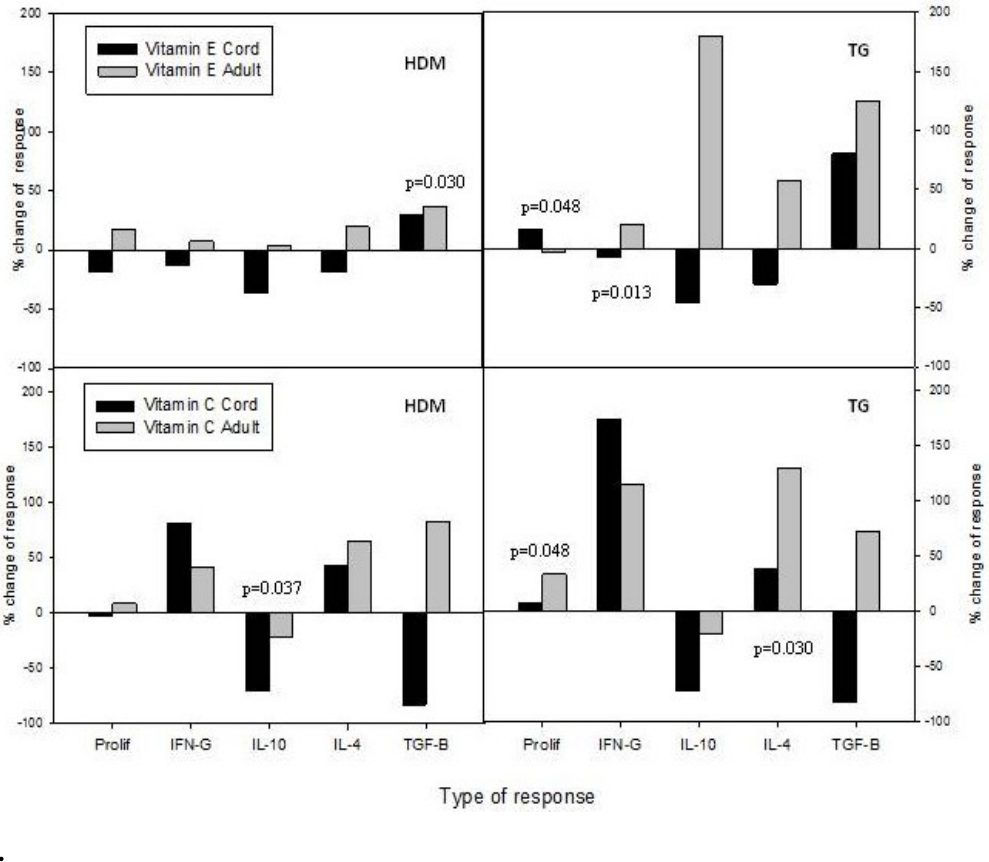
Figure 5. Summary of differential effects of vitamin E or C supplementation on CBMC or PBMC responses to allergen . Proliferation and secretion of IFN-γ, IL-10, IL-4 and TGF-β are expressed as the mean percentage change between paired unsupplemented and supplemented cultures. Significant p values for differences in responses between paired samples in cultures with or without vitamin supplementation are shown on the relevant